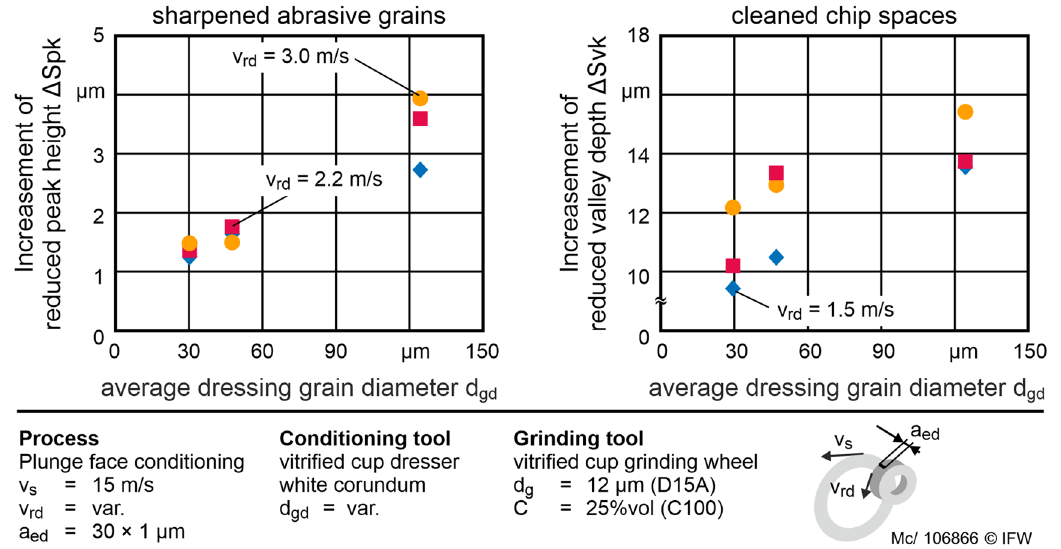
Figure 7. Influence of the average grain diameter of the conditioning tool on the surface parameters Spk and Svk. Its influence is five times greater in Svk than in Spk. With increasing grain diameter, both Spk and Svk increase.